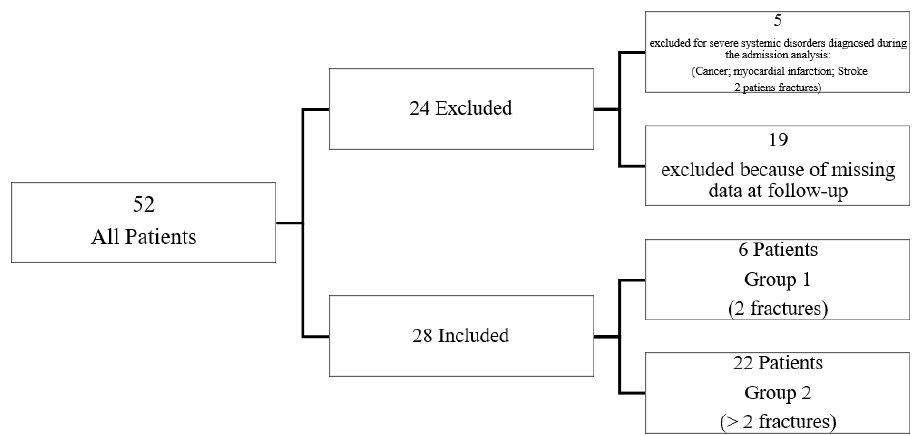
Figure 1. Selection of the study population.